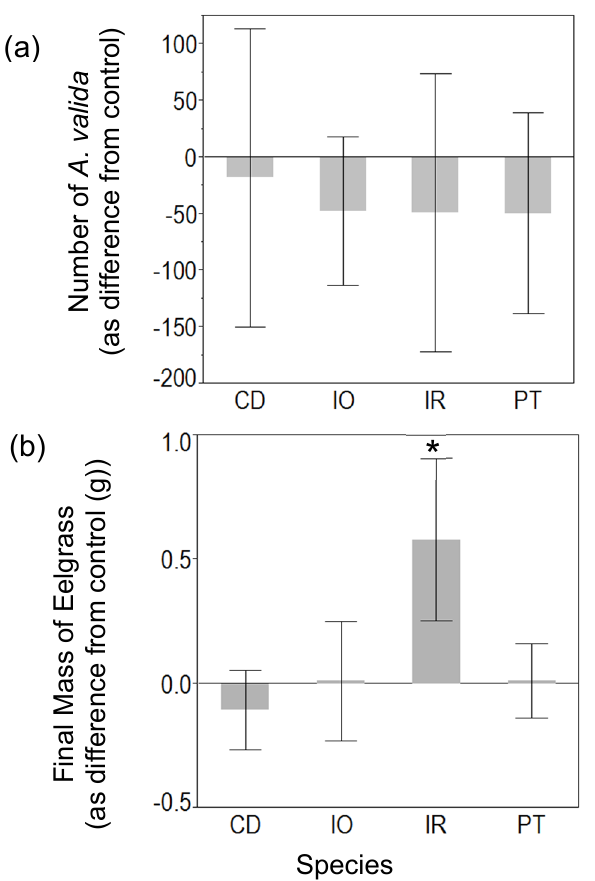
Figure 4. Results from Phase 2 of the mesocosm experiment (addition of Ampithoe valida to tanks already established with the other species or to the previous no-grazer controls) showing ( a ) final number of A. valida and ( b ) final mass of eelgrass. Error bars are 95% confidence intervals. Asterisks indicate confidence intervals that do not overlap with the control value of zero. Species abbreviations as in Figure 1. Sample sizes were: CD: n = 18, IO: n = 19, IR: n = 19, and PT: n =